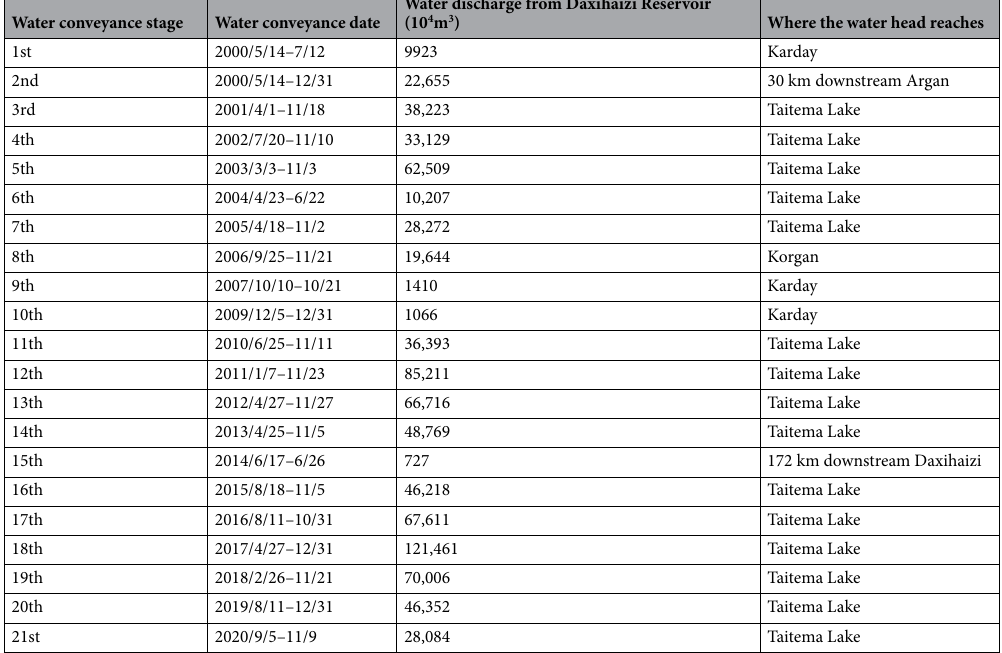
Table 1. Information of ecological water conveyance in the lower reaches of Tarim